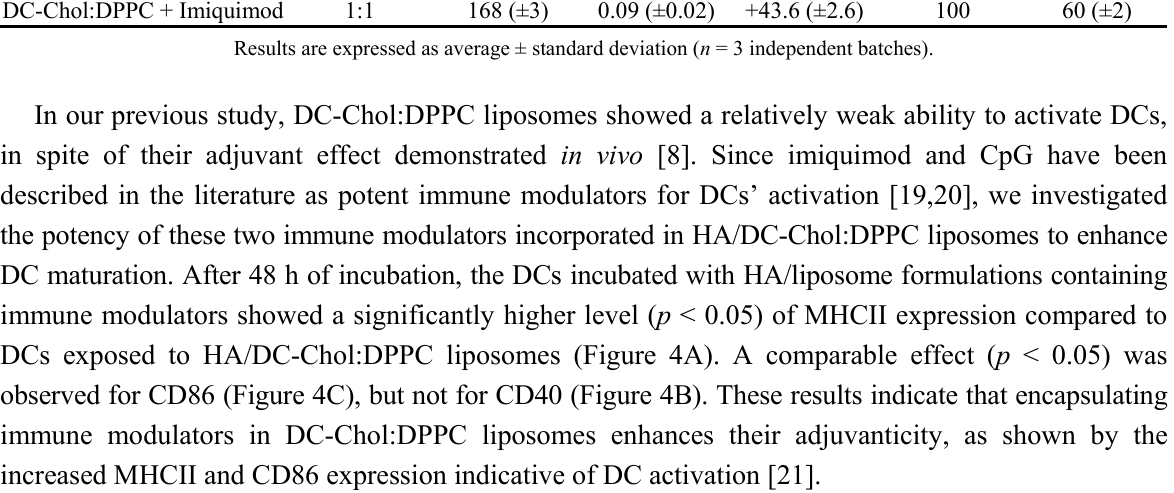
Table 3. Physicochemical characteristics of aluminium hydroxide and adjuvanted cationic liposomes after mixing with HA. Formulation Molar-ratio